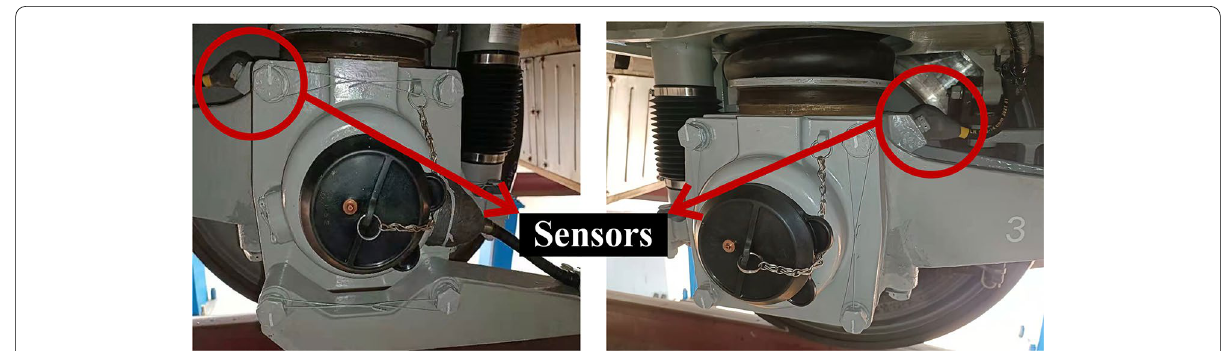
Figure 10 Bogie and the installation diagram of sensor